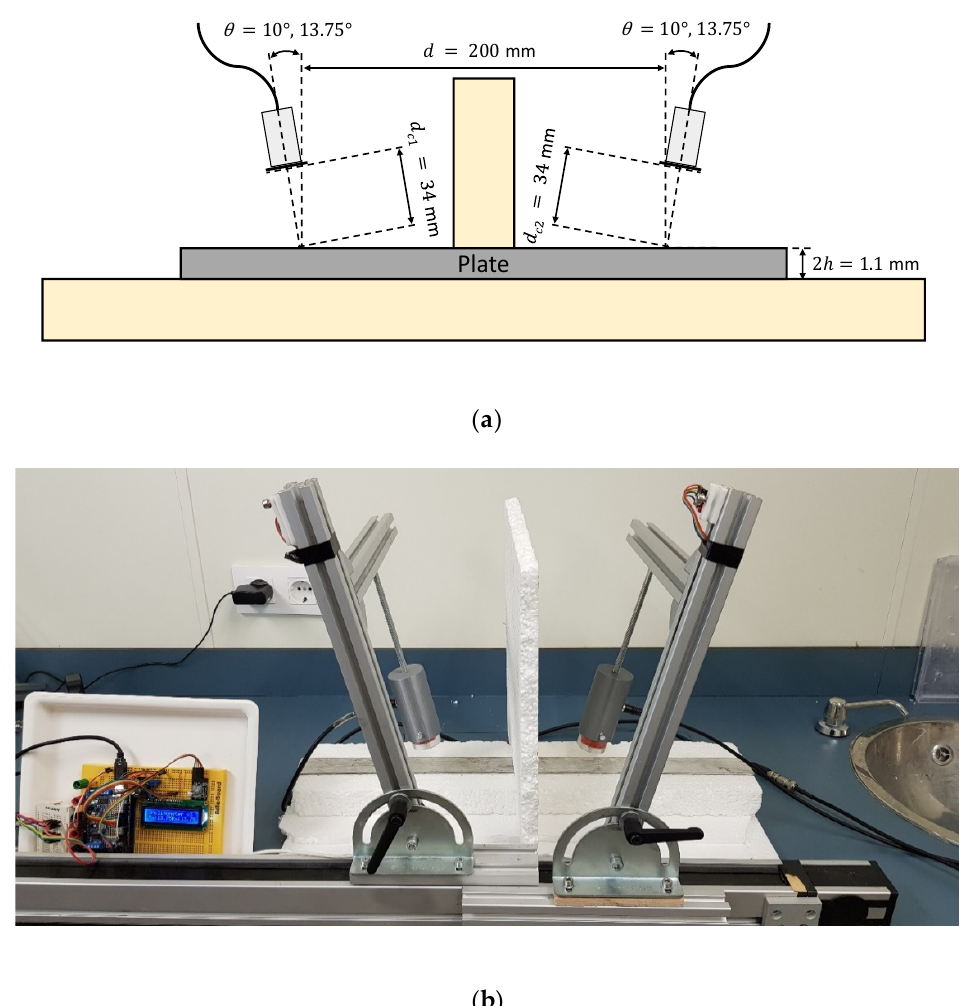
Figure 13. Air coupling setup.to measure the stainless-steel plate: ( a ) Schematic; ( b ) Photograph.